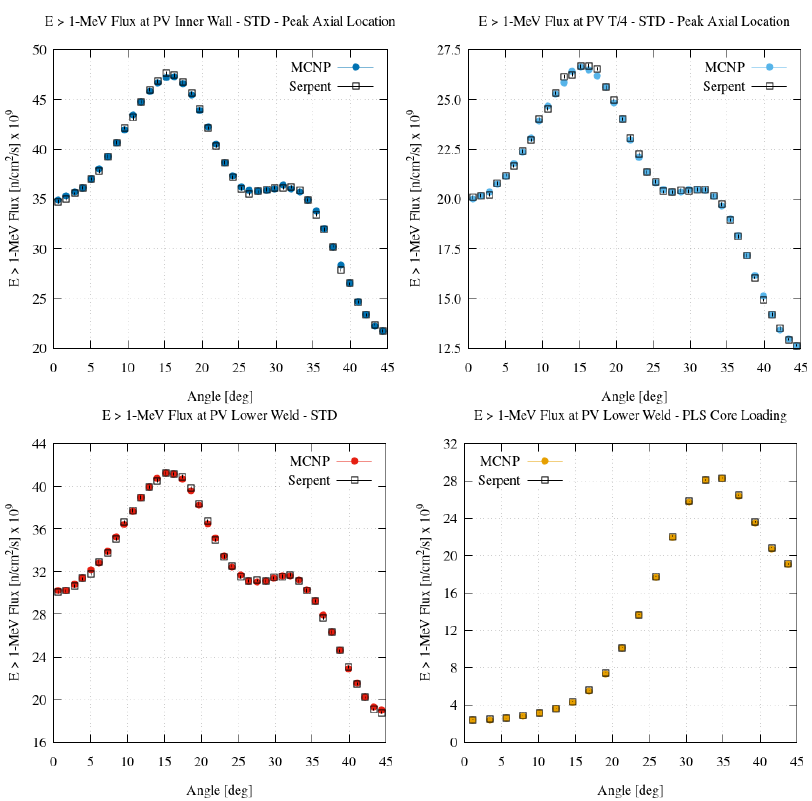
Figure 2 : Fast neutron fluxes (and their statistical uncertainties) at various locations for the STD and PLS computational benchmarks using identical geometry and VR techniques ( Case A